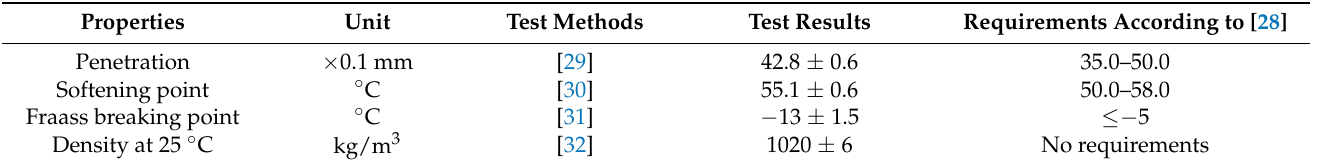
Table 1. Basic properties of the 35/50 penetration-grade